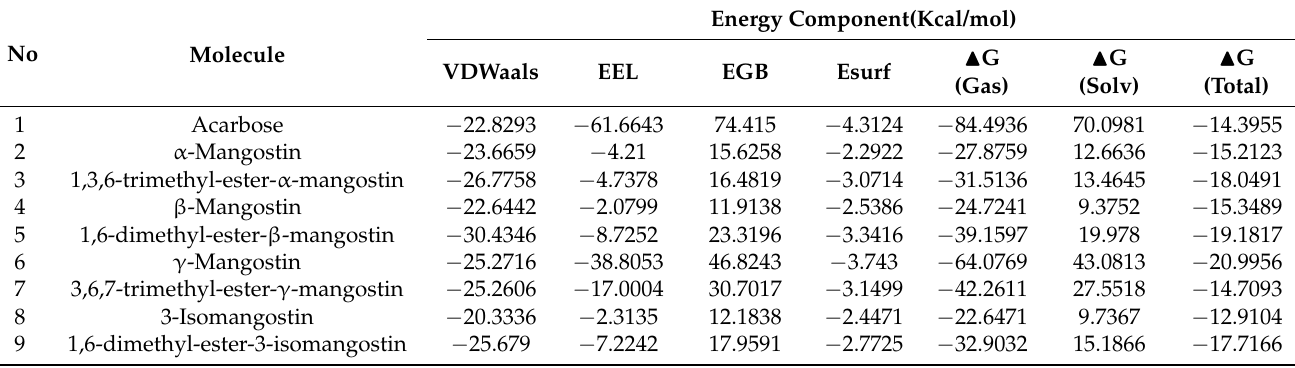
Table 4. Energy components generated from the simulation results of molecular dynamics. All derived compounds had better free energy values than the original, but differed from mangostin, whose derivative compounds were not as good as the original.